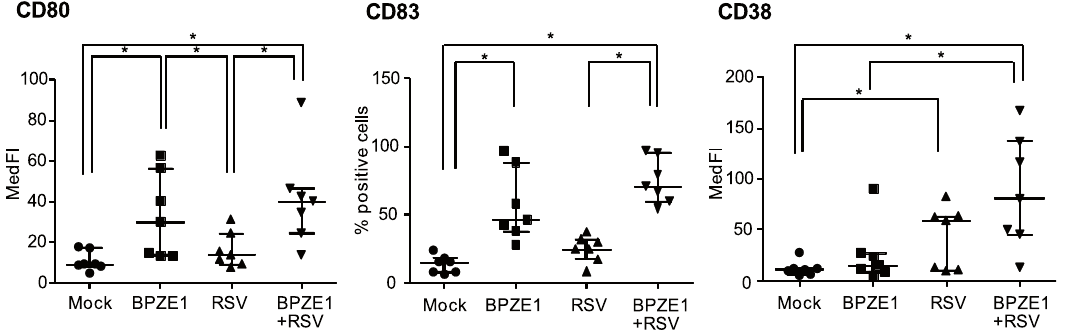
Figure 1. Impact of BPZE1 on phenotypic maturation of RSV-infected MDDC. MDDC were treated with BPZE1 (bacteria/cell ratio 100:1), RSV (MOI of 1) or both. After 24 h, cells were analyzed for the indicated surface markers associated with a mature phenotype. Mock-infected cells were used as control. Fluorescence data are reported as median fluorescence intensity (MedFI) for CD80 and CD38, and as percentage of positive cells for CD83. Values are expressed as medians with interquartile range of seven independent experiments performed with MDDC obtained from different donors. Statistical significant differences are indicated by * ( P # 0.0083).